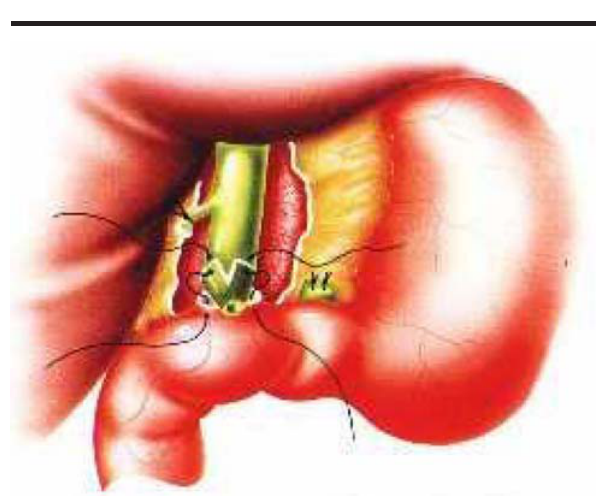
FIGURA 10 - Desenho mostra a sutura da parede posterior da eversão colédoco com a parede posterior do duodeno.